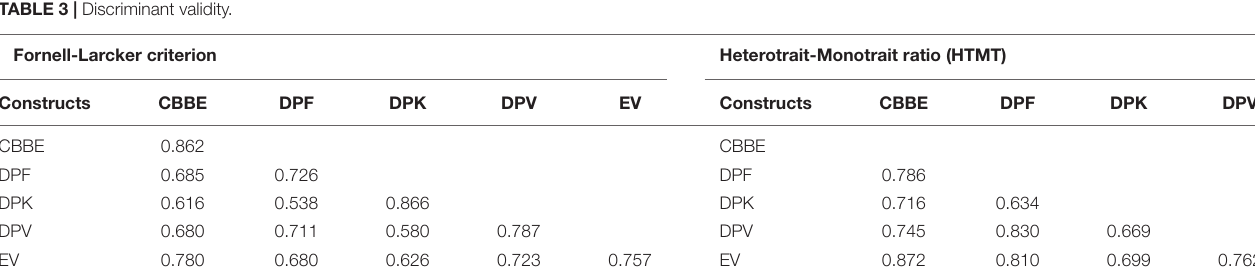
TABLE 3 | Discriminant